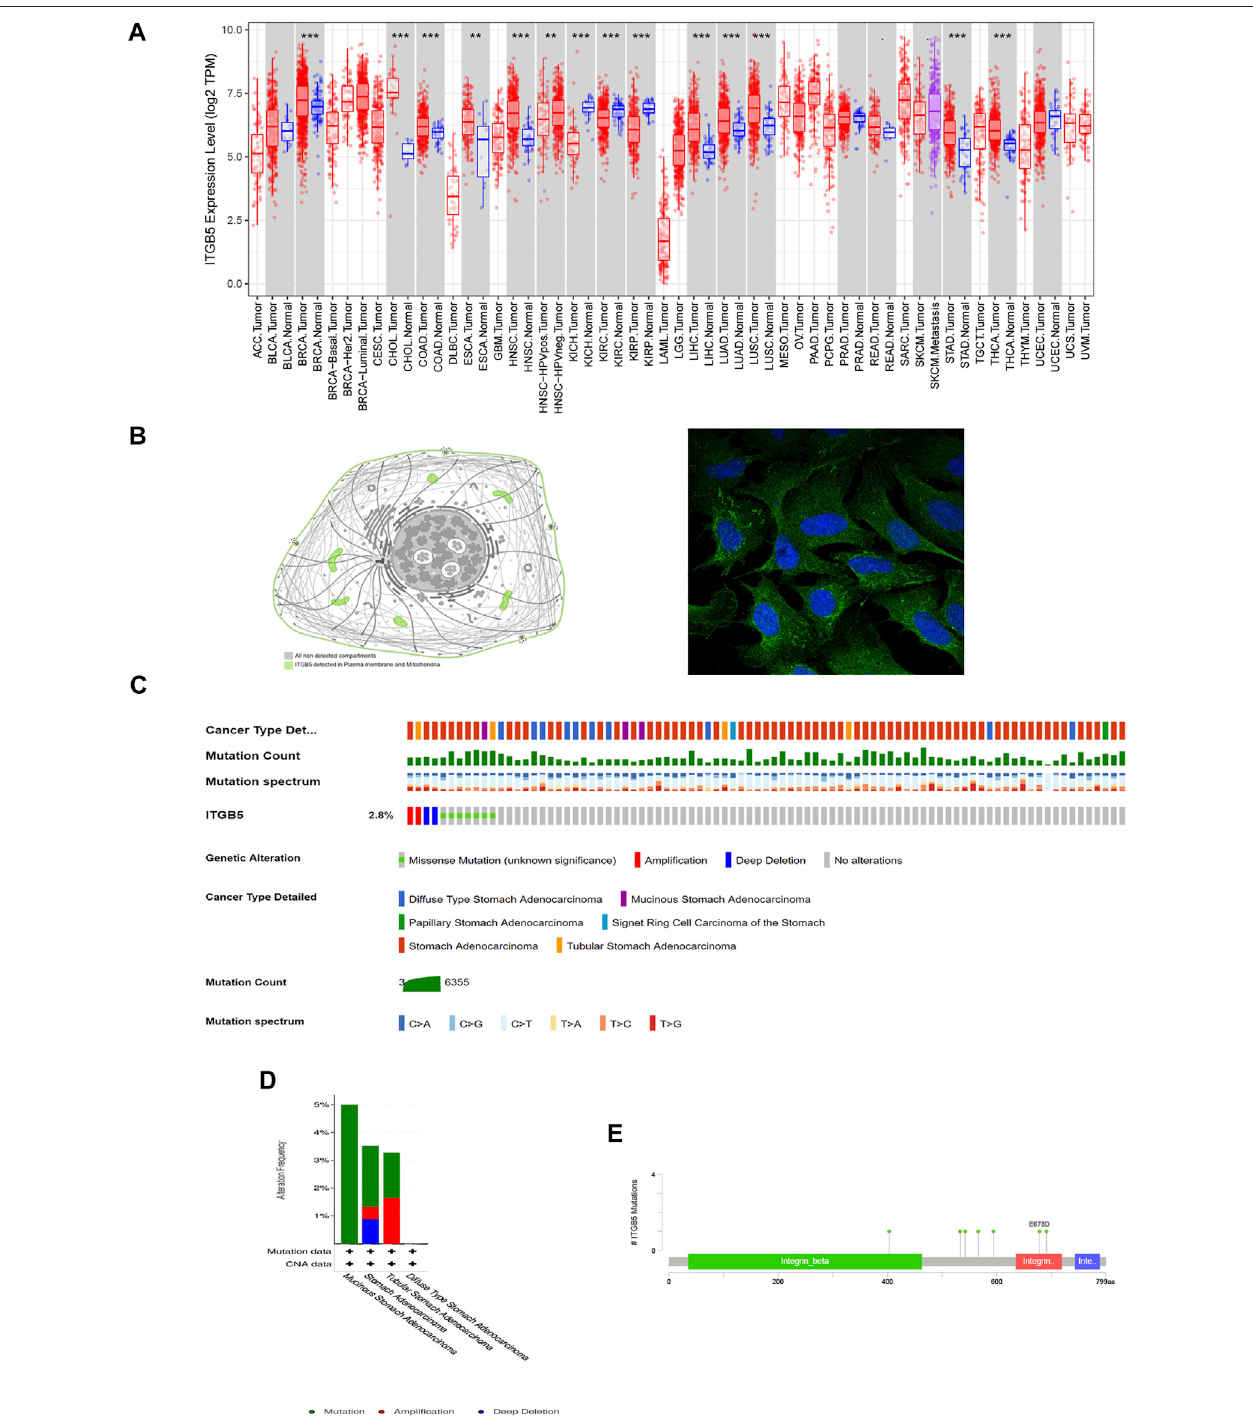
FIGURE 6 | Basic characteristic of ITGB5. (A) Expression of ITGB5 in different types of cancer. (B) Subcellular location and immuno fl uorescence images of ITGB5 expression in GC cells from HPA. (C – E) Detailed mutation information of ITGB5 in GC.